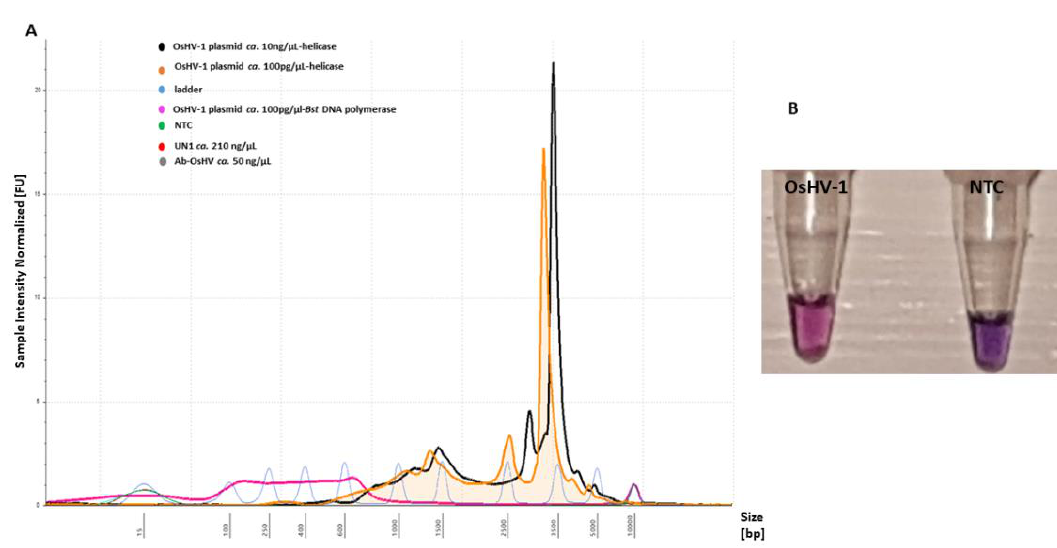
Figure 6. LAMP primer evaluation for amplification of the OsHV-1 plasmid (T = 65 ◦ C, t = 10 min) and sensitivity with the addition of Tte UvrD helicase enzyme: ( A ) electropherogram comparison profiles of positive (OsHV-1 plasmid) and negative templates (NTC, UN_1 and AbHV) analysed using Tape Station Analysis Software A.02.02 (Agilent Technologies) for assessment of progressive increase of amplified LAMP product. Positive templates show a size shift of 350–5000 bp. ( B ) Colorimetric assessment of amplified LAMP products for positive (OsHV-1) (pink) and NTC (violet) templates using HNB.